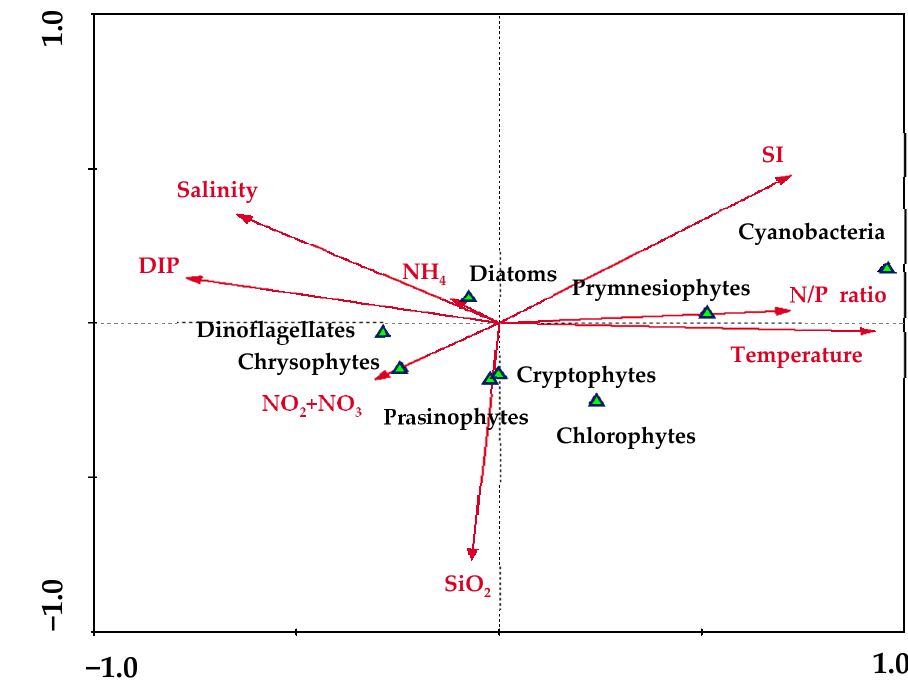
Figure 3. Canonical component analysis (CCA) to determine relationships among the environmental factors and phytoplankton communities.